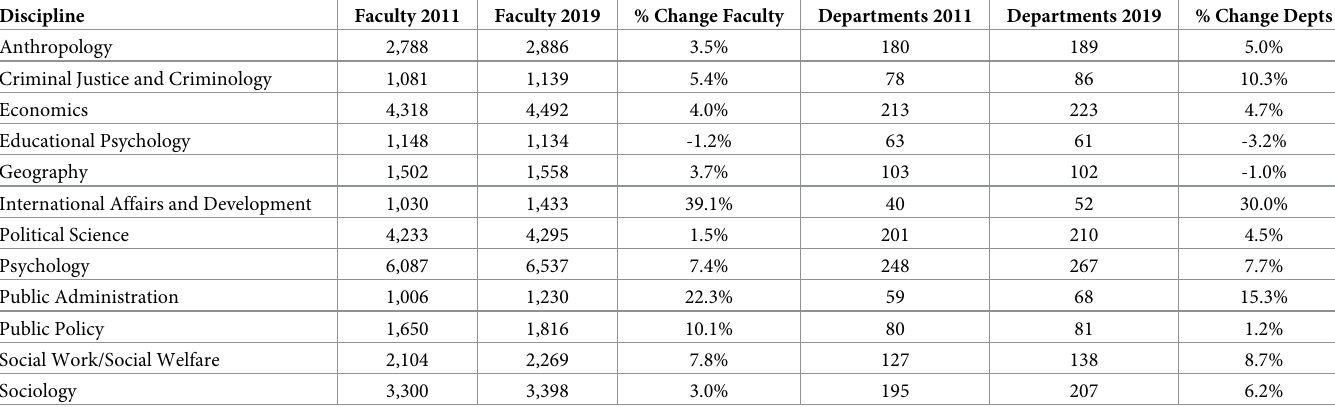
Table 1. Faculty member population and number of academic departments in the 2011 and 2019 database snapshots.